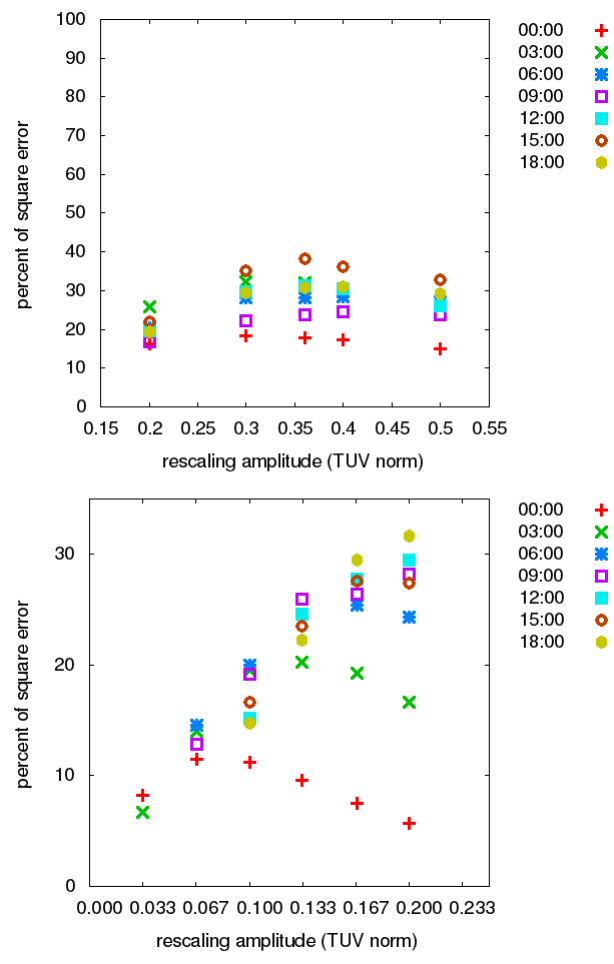
Figure 5. Square norm of error orthogonal projection onto the sub- space of the first 12 bred vectors (percentage of error square norm), as in Fig. 4, but plotted here as a function of rescaling amplitude. Different symbols are used in each panel to mark different times (UTC, 26 September 2006). Top panel: control trajectory 18H (large initial error), longer rescaling period 30min. Bottom panel: control trajectory R21 (small initial error), shorter rescaling period 15min. The same data are plotted as a function of lead time in Fig.